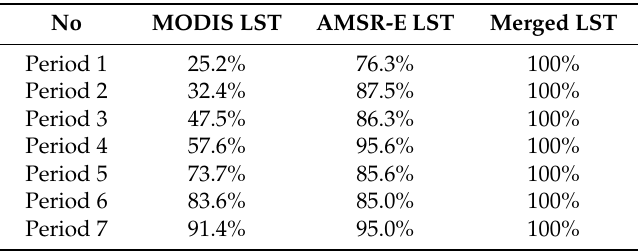
Table 4. Availability of MODIS LSTs, AMSR-E LSTs, and merged